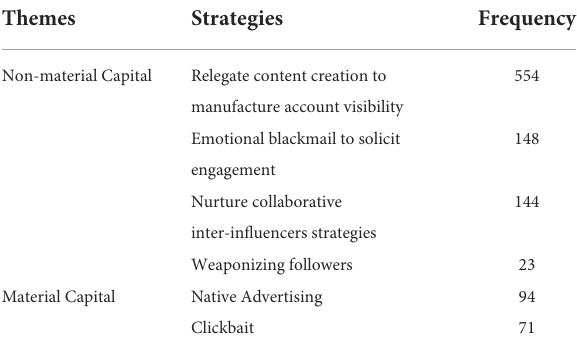
TABLE 1 Extracted themes and